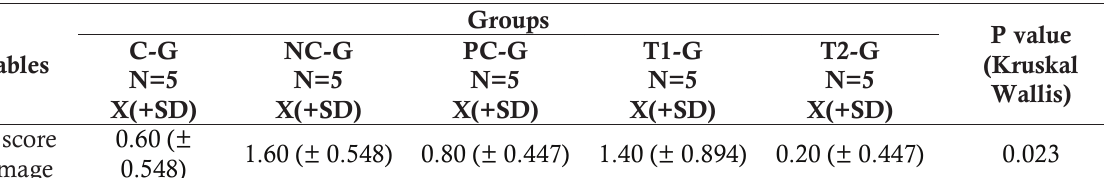
Table 1. Wistar rats liver cell damage score